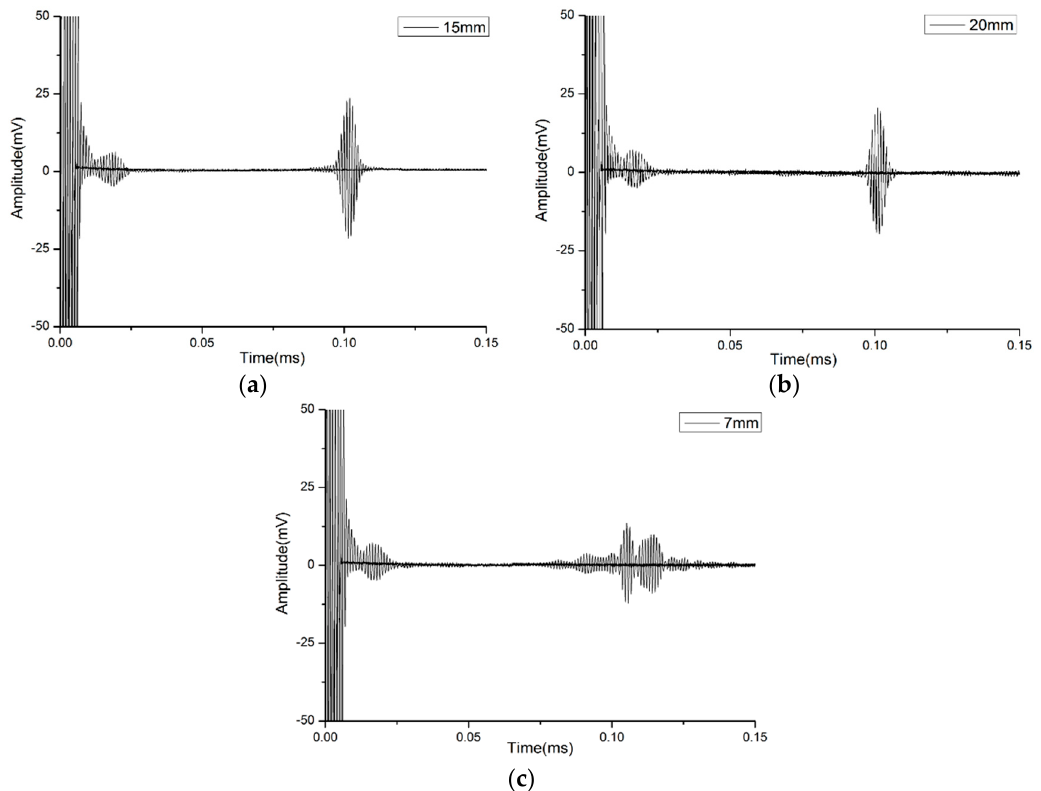
Figure 12. The reception signals of No. 1, No. 3 and No. 4 waveguide bars: ( a ) Width 15 mm; ( b ) Width 20 mm; ( c ) Width 7 mm.